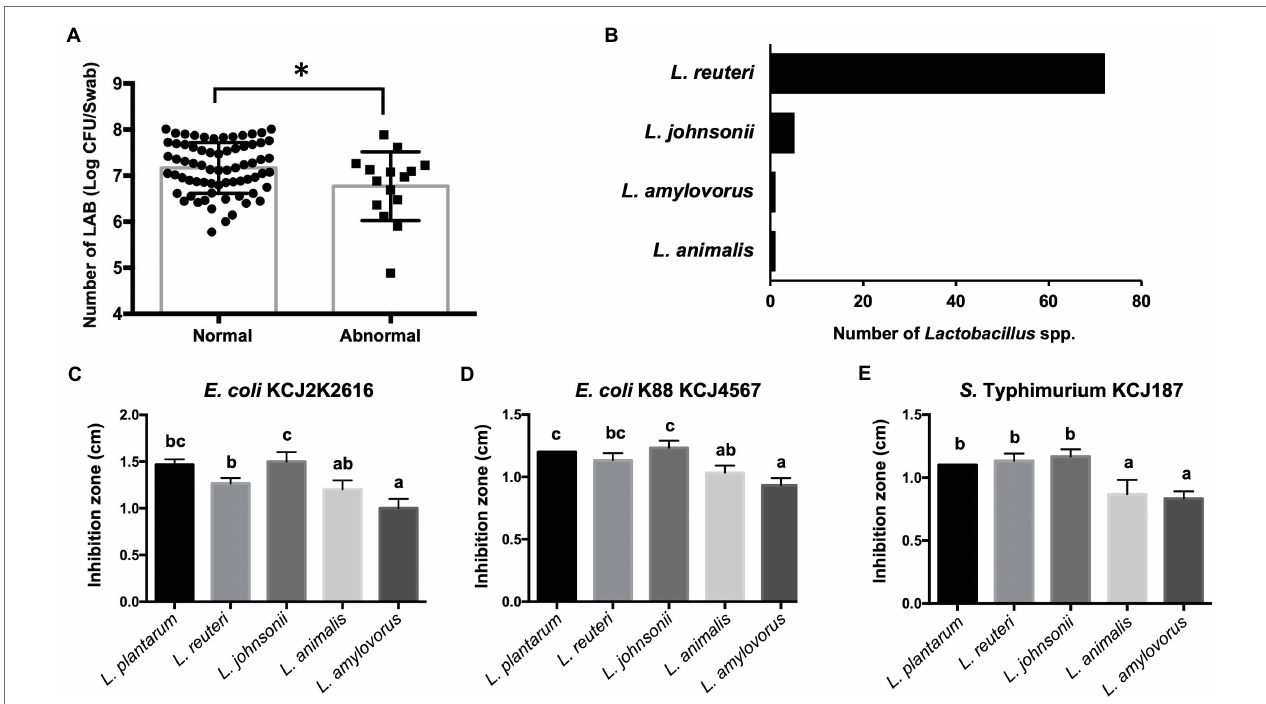
FIGURE 6 | Isolation of Lactobacillus strains and their antimicrobial activity. (A) The concentrations of lactic acid bacteria (LAB) in normal and abnormal feces. In the bar graph, the asterisk reflects they are significantly different ( p < 0.05) based on the Student’s t -test. (B) Number of Lactobacillus spp. isolated from healthy calves identified by 16S rRNA gene sequencing. (C-E) Antimicrobial activity of Lactobacillus spp. against pathogenic strains. Bars with different letters indicate significant difference ( p < 0.05) based on one-way ANOVA followed by an F -test and Tukey’s HSD test for pairwise comparison of multiple